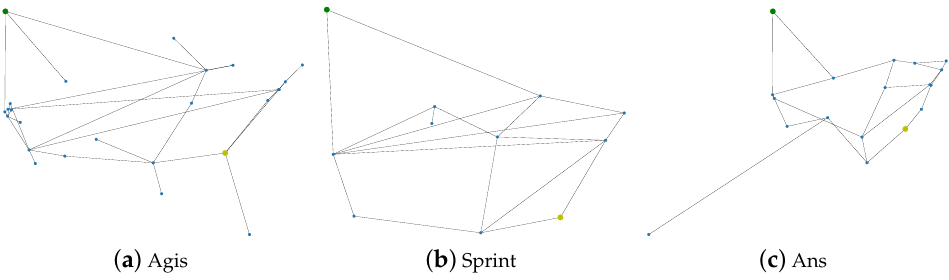
Figure 9. Network Topology of Different ASes. ( a ) Agis topology. ( b ) Sprint topology. ( c ) Ans topology.